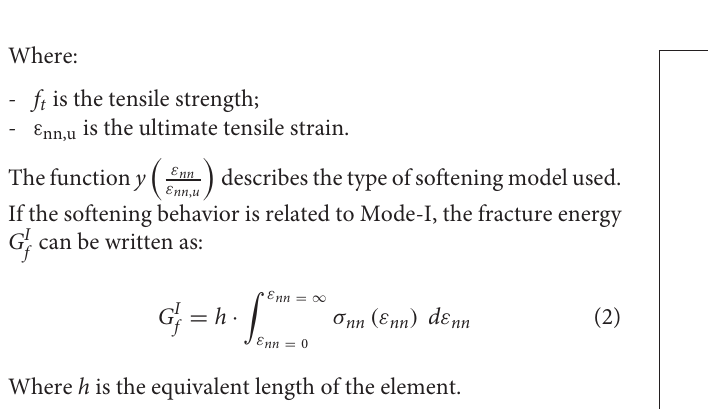
FIGURE 2 | Stress-strain behavior for: (A) tensile linear softening; (B) tensile brittle; (C) compression constant.